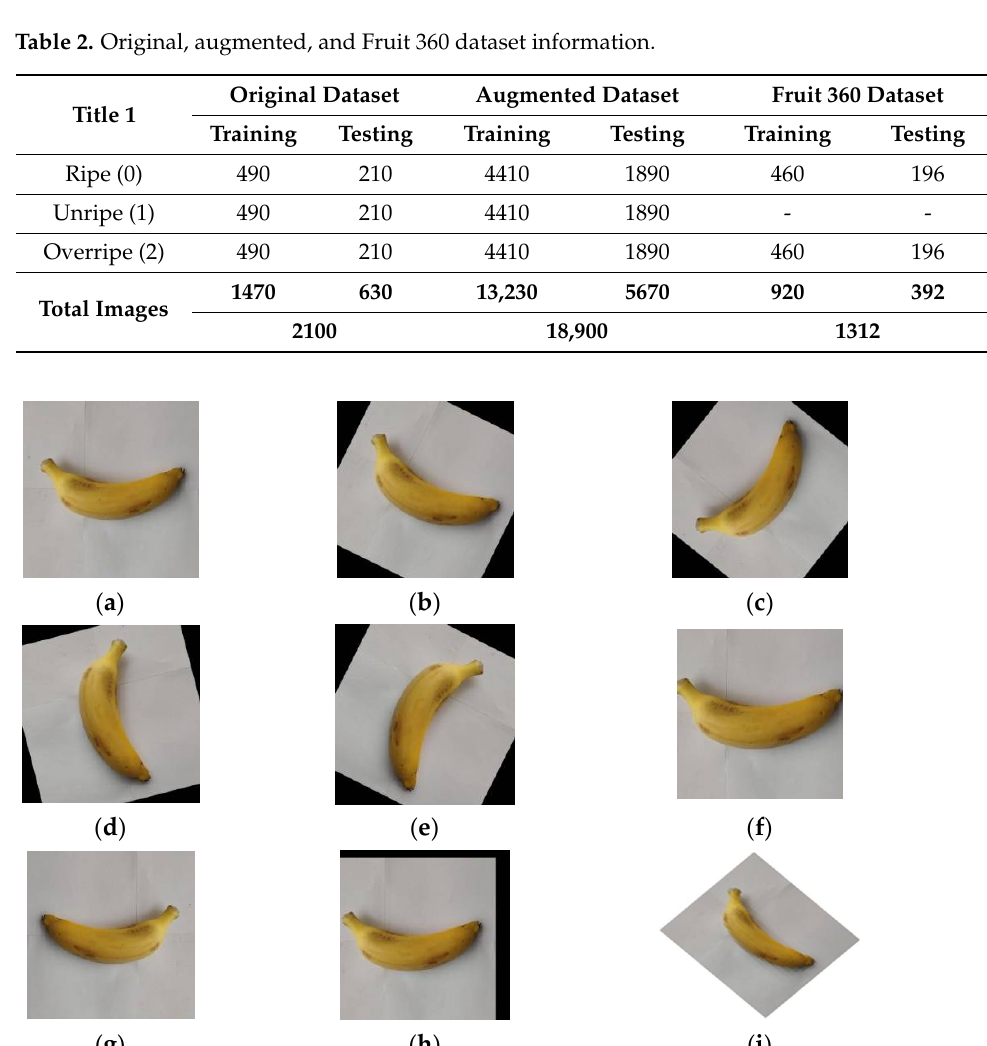
Figure 4. Ripe image dataset position augmentation: ( a ) original image, ( b ) random rotation 65 ◦ , ( c ) random rotation 135 ◦ , ( d ) random rotation 205 ◦ , ( e ) random rotation 275 ◦ , ( f ) center crop, ( g ) horizontal flip, ( h ) affine transformation, and ( i ) compose transformation of 45 ◦ rotation and horizontal flip.